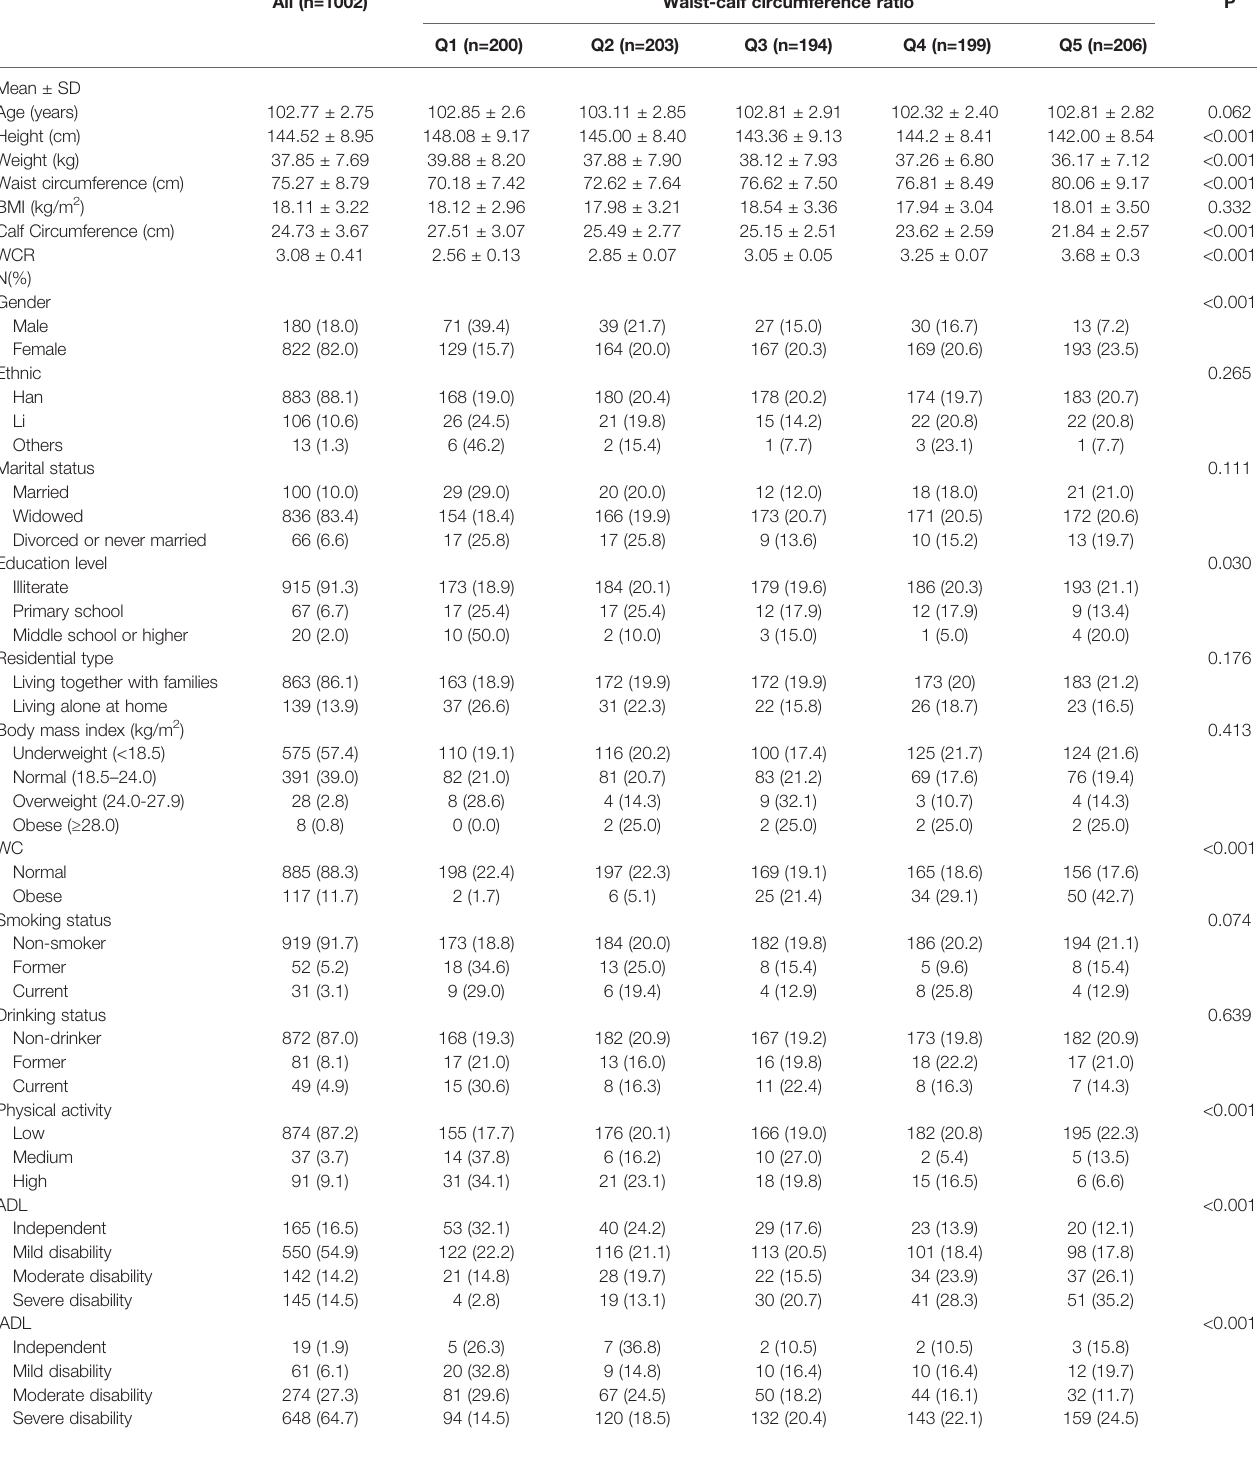
TABLE 1 | Sociodemographic variables of the China Hainan centenarian cohort study